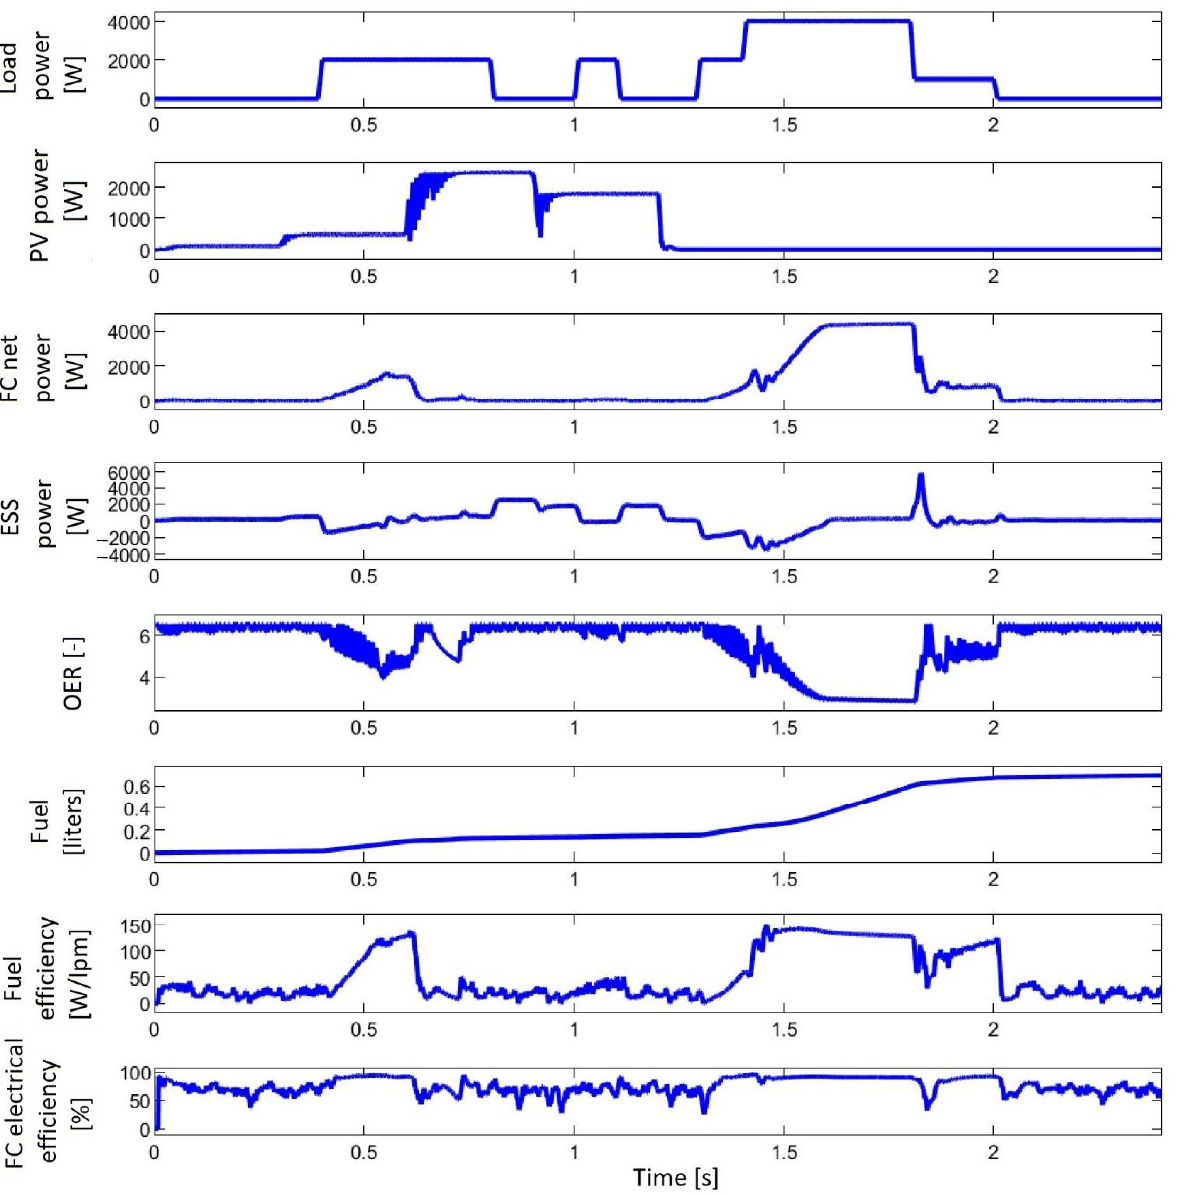
Figure 11. The behavior of the PV/FC/ESS system using strategy S2 in the scenario SC3. The FC system will generate additional power in the time interval when P PV < P Load (between 4 and 6 s) and the batteries will operate in charge-sustaining mode, as shown in Figure 11. The total fuel consumption is 0.74784 L, 0.696 L and 0.682 L for strategies S0, S1 and S2. Therefore, the fuel economy for strategy S2 compared to strategy S1 is of 0.014 L, which means 0.35